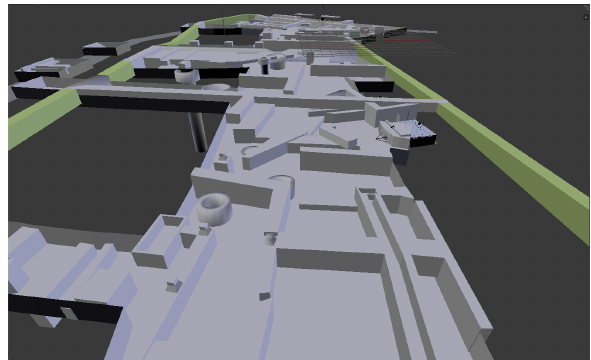
Figure 3: The 3D model of the archaeological strata retrieved from documentation which includes vestiges from different his- torical periods